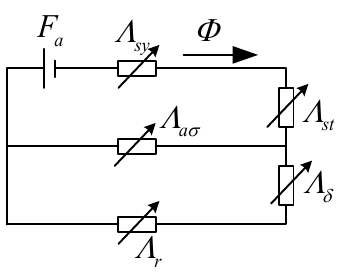
Figure 11. The equivalent magnetic circuit of the armature magnetomotive force